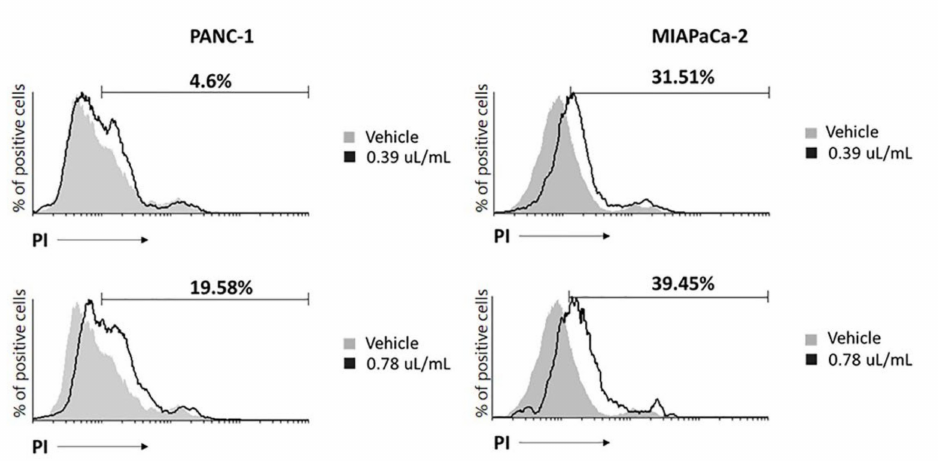
Figure 2. EPO induces cell death in PANC-1 and MIAPaCa-2 after 48 h. Data represent the percentage of PI-positive cells and are representative of one of three separate